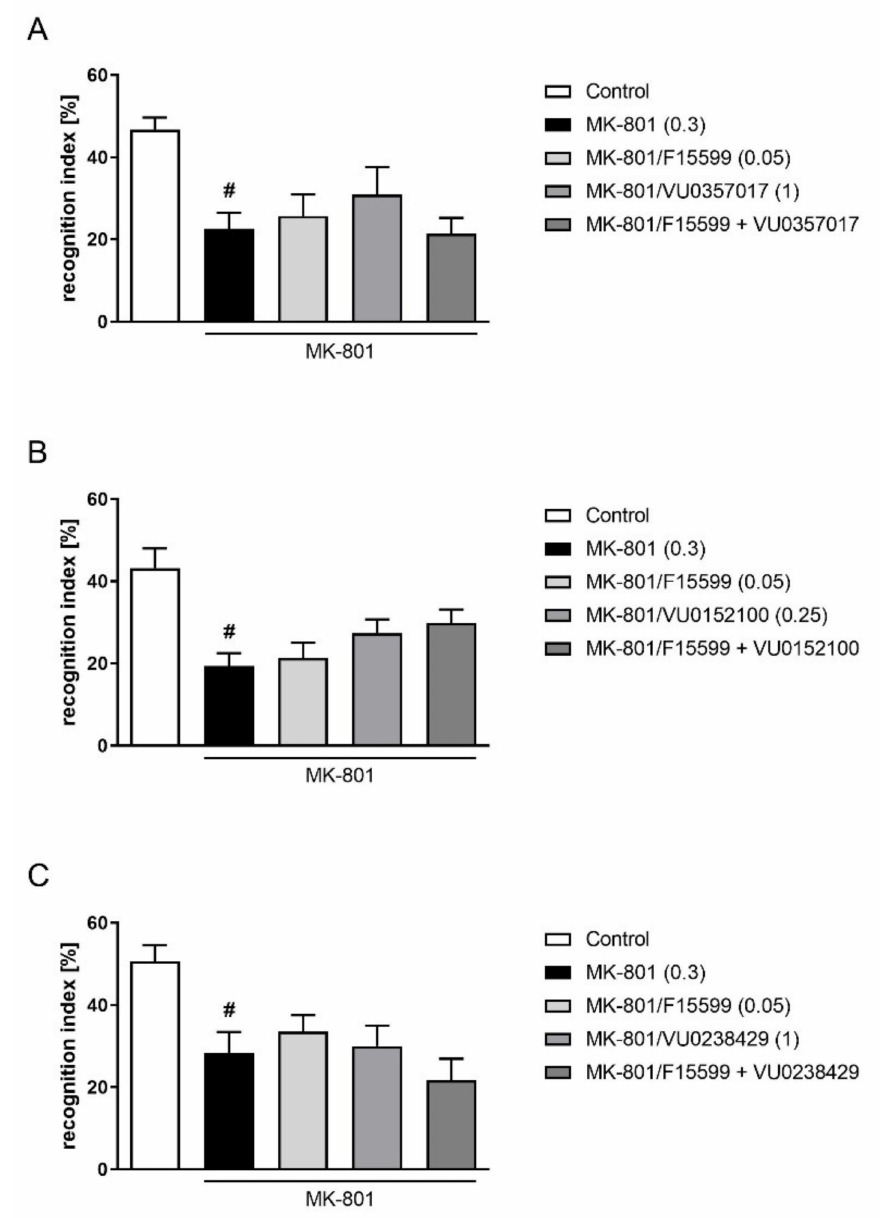
Combined administration of F15599 at a dose of 0.1 mg/kg together with VU0357017 (10 mg/kg), VU0152100 (1 mg/kg), or VU0238429 (5 mg/kg) had no effect on spontaneous alternations in the Y-maze test (Figure 7).